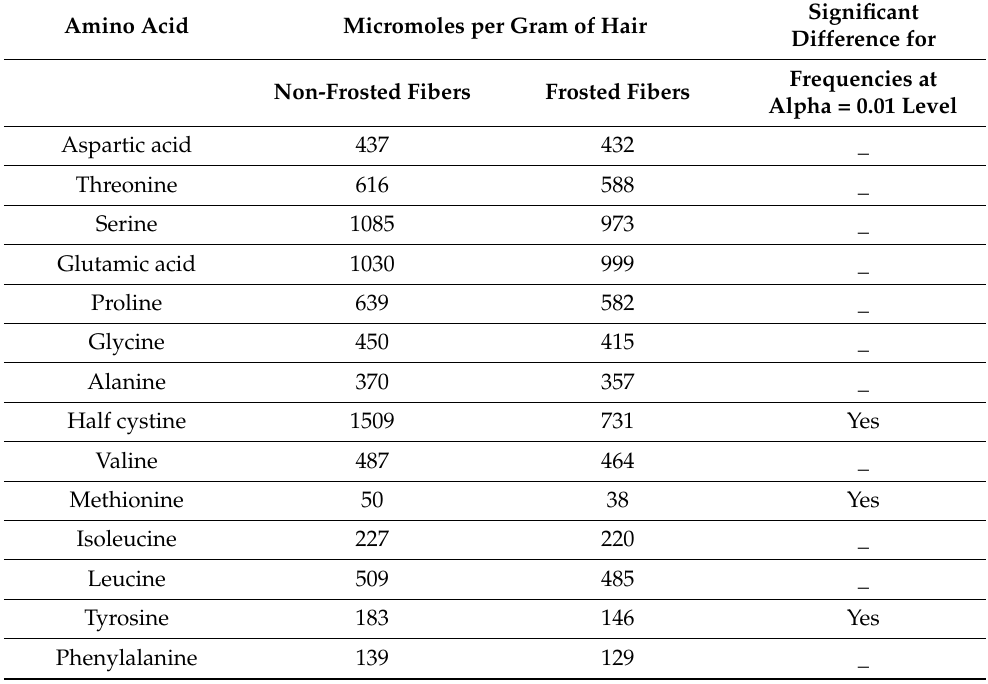
Table 10. Amino acids from frosted vs. non-frosted hair [95–97]. Amino